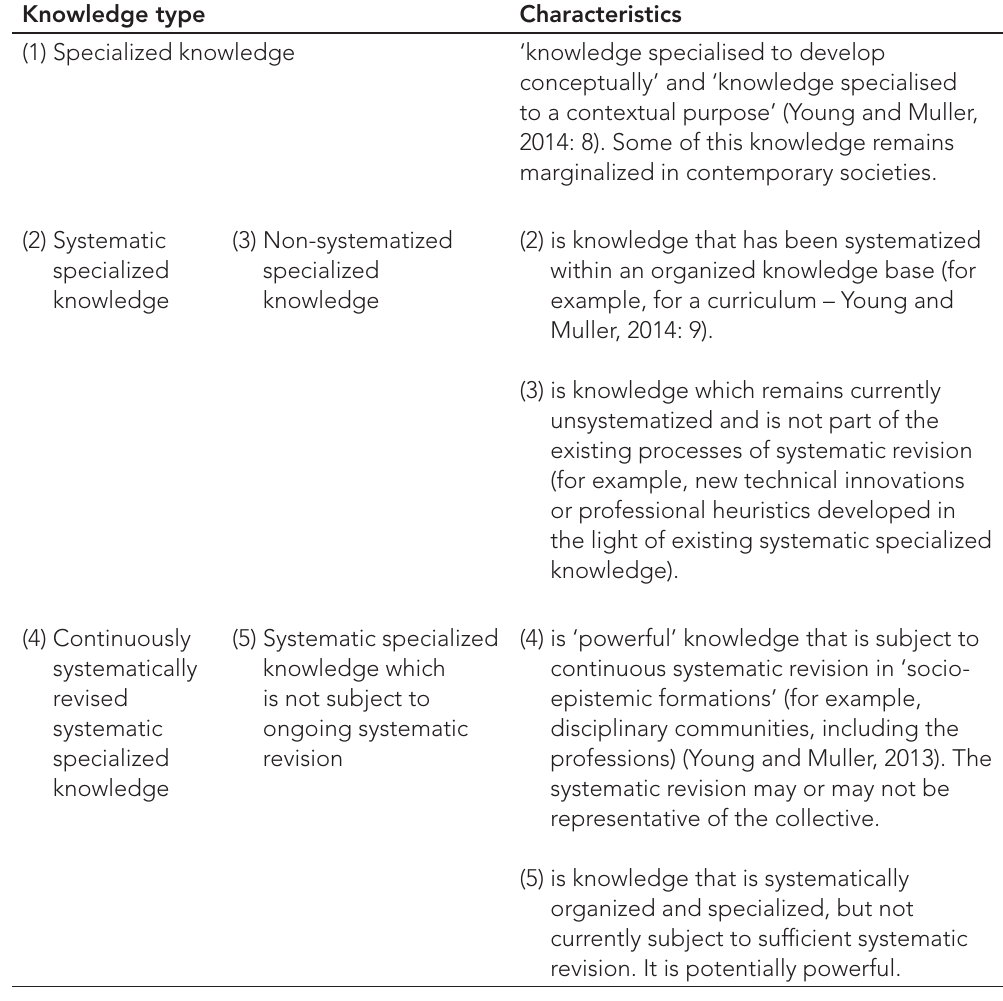
Table 1: Specialized and systematic knowledge Knowledge